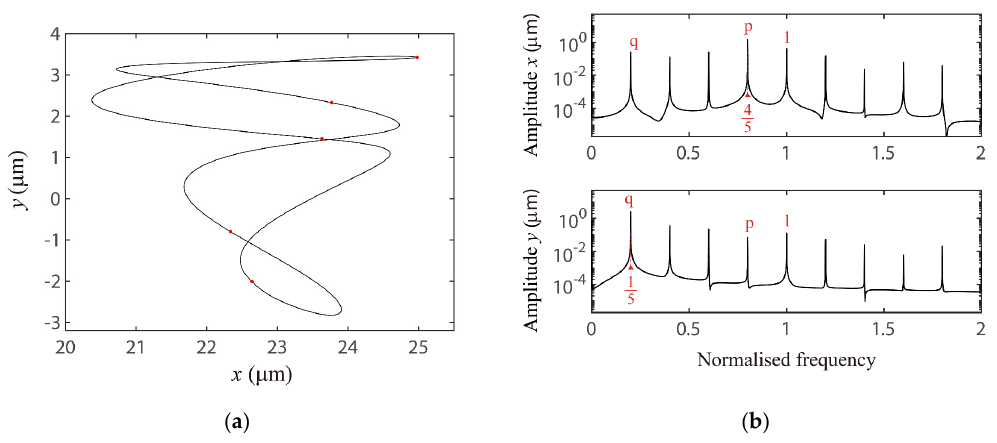
Figure 32. Response characteristics of the VC quasi-period motion when Ω = 211.9492 rad/s (i.e., in literature [14], ω s takes 5250 rpm), ( a ) orbit (black line) and its Poincare mapping (red dots), ( b ) frequency spectrum.